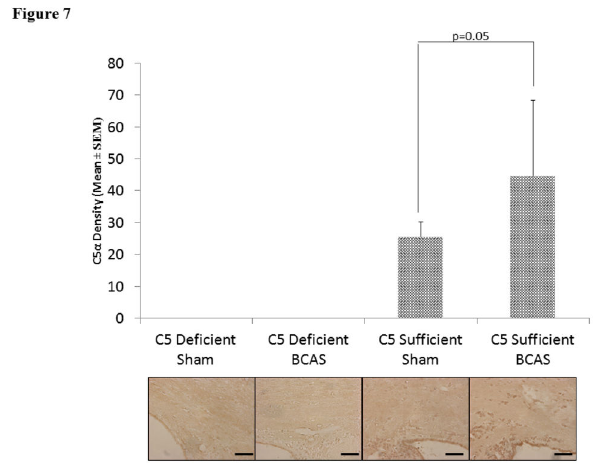
Figure 7. C5 deposition: C5α staining in the medial corpus callosum in C5 sufficient and C5 deficient mice subjected to sham and BCAS operations. Above: C5α density in each experimental group (arbitrary units). Below: Representative coronal sections of the right corpus callosum with high magnification insert (medial corpus callosum). Bars indicate 50µm. n=10 C5D/ BCAS, n=10 C5D/ sham, n=9 C5S/ BCAS, n=9 C5S/ sham. doi: